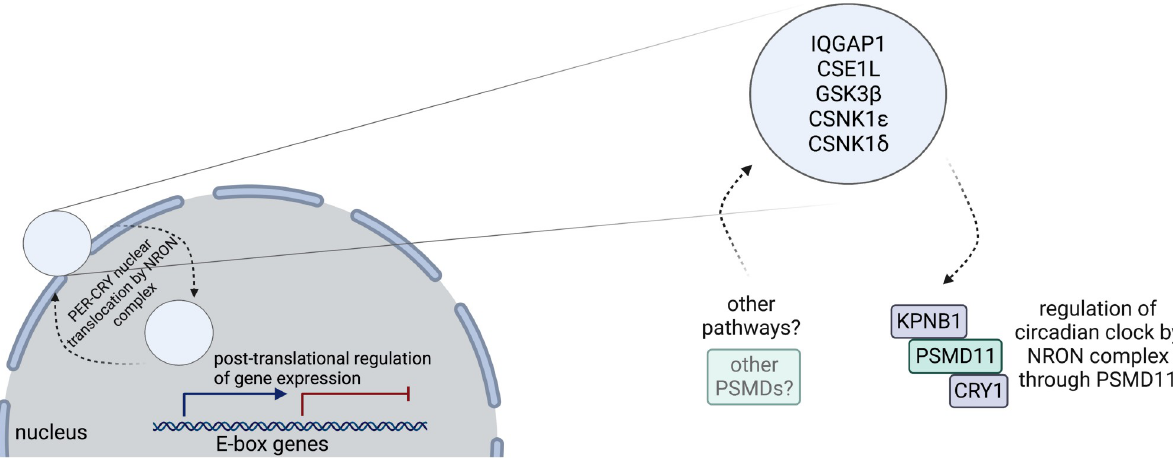
Fig 5. NRON complex regulates circadian clock through PSMD11 and has a potential to regulate other pathways. A model to explain the role of the NRON complex at the perinuclear area to transfer proteins between cytoplasm and nucleus. The complex is used by circadian clock and NFAT pathways and potentially is used by different pathways as well. PSMD11 controls the regulation of circadian clock through the complex, other PSMD proteins are suspected to control other pathways as a part of the complex. Created with BioRender.com.